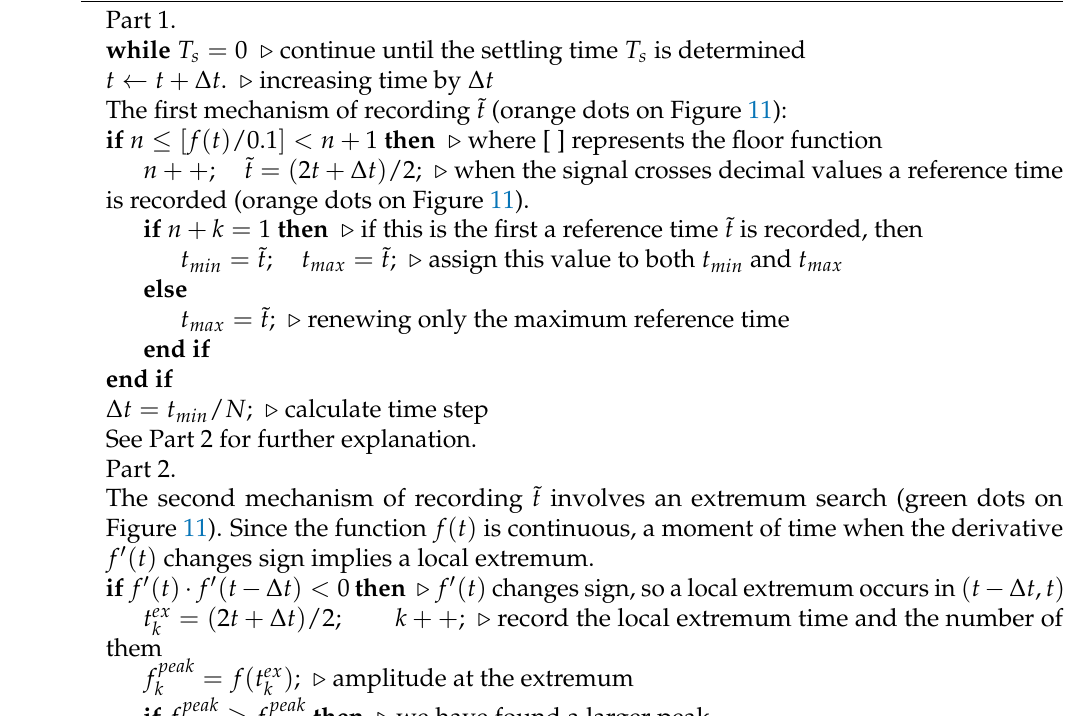
Algorithm 1 Processing of the given signal. Using the following algorithm, we gather large statistical